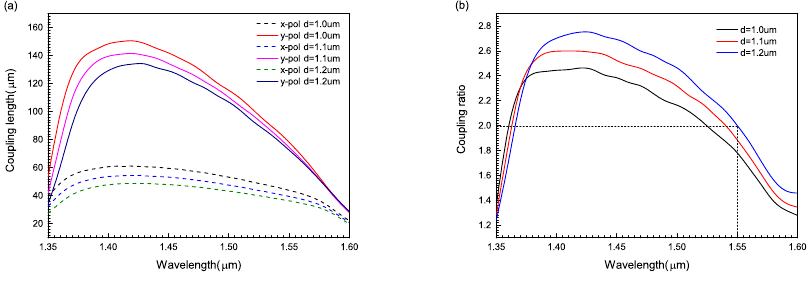
Figure 6. Influence of pore diameter change in cladding on coupling length ( a ) and coupling ratio ( b